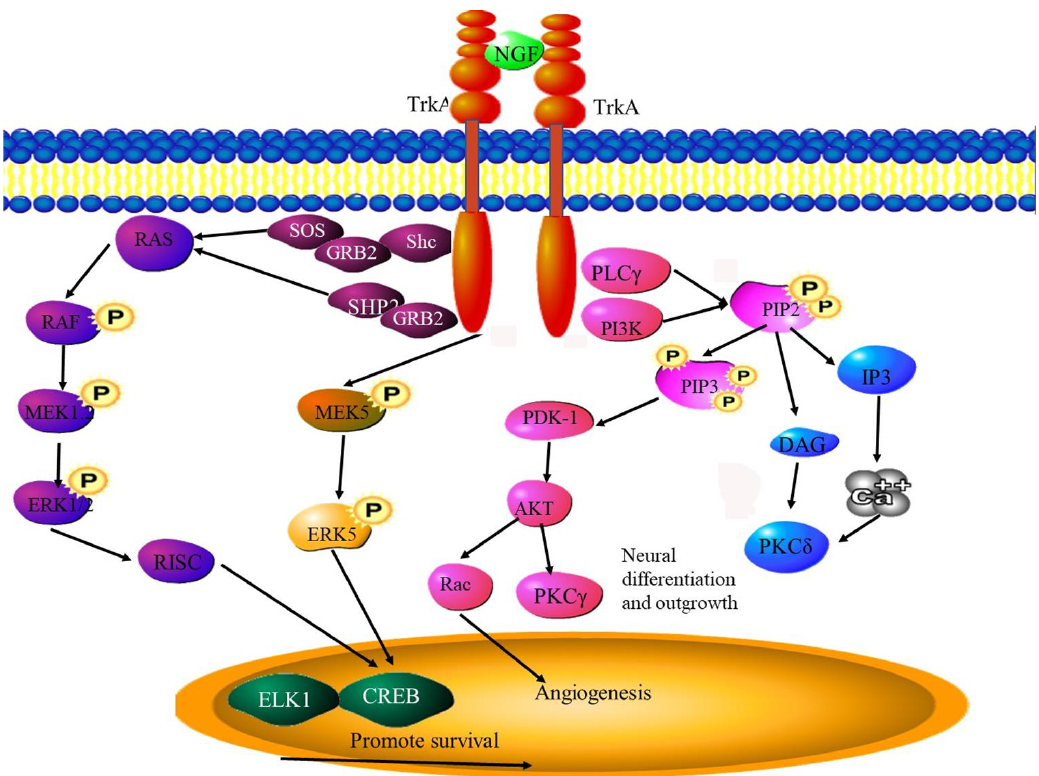
Figure 6. NGF signaling pathways. NGF binding to TrkA and p75NTR receptors promotes neuronal growth. The activation of the ERK signaling pathway promotes the transcription of pro-angiogenic and pro-neurogenic genes as in other neurotrophic and growth factor pathways. CREB—Cyclic AMP-responsive element-binding protein, ELK—ETS domain-containing protein, eNOS—Endothelial NOS, ERK—extracellular signal-regulated kinase, GRB1/2—Growth factor receptor-bound protein 1/2, MEK—Mitogen activated kinase, PDK—Pyruvate dehydrogenase kinase 1, PIP-2/3—phospholipase, PI3K—Phosphoinositide 3-kinase, PKC—Protein kinase C, PLC γ —Phosphoinositide phospholipase C, Shp2—Src homology region 2, SOS—Son of